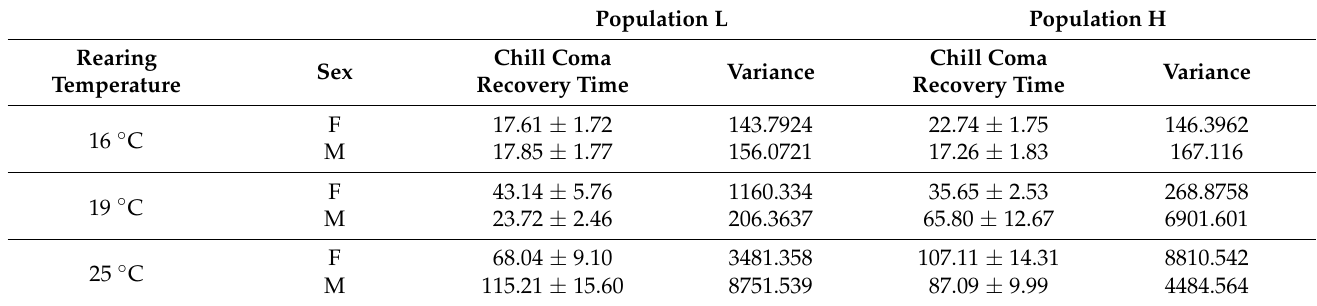
Population x Rearing temperature x Sex; LS Means